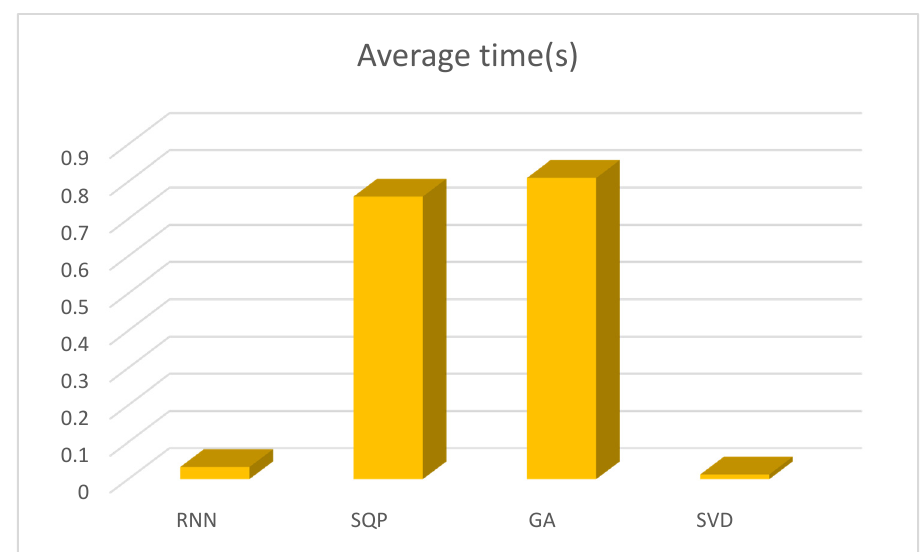
Figure 7. MSE of different optimization algorithms.